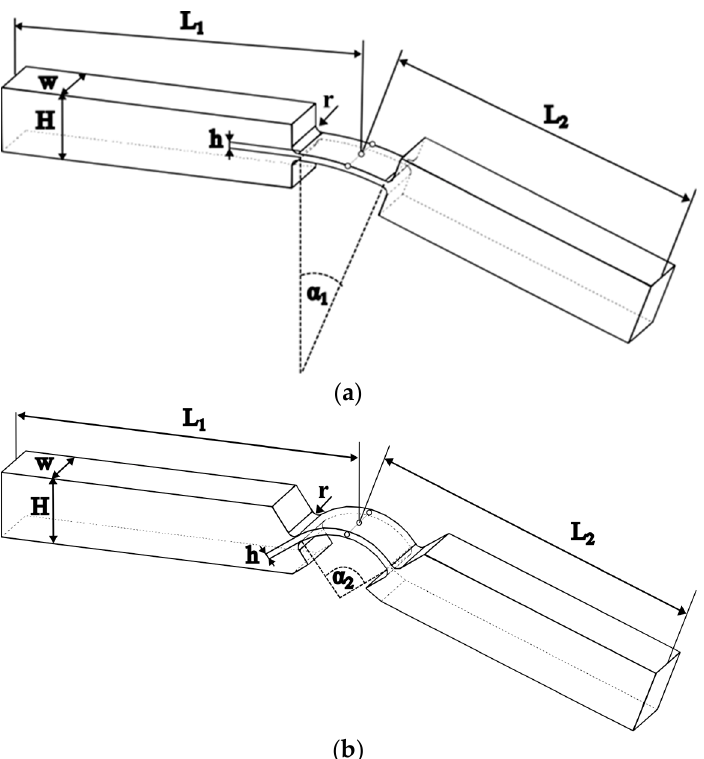
Figure 5. Compliant finger: ( a ) Curved flexure hinge with a α 1 = 21-degree bend and ( b ) Curved flexure hinge with a α 2 = 90-degree bend.